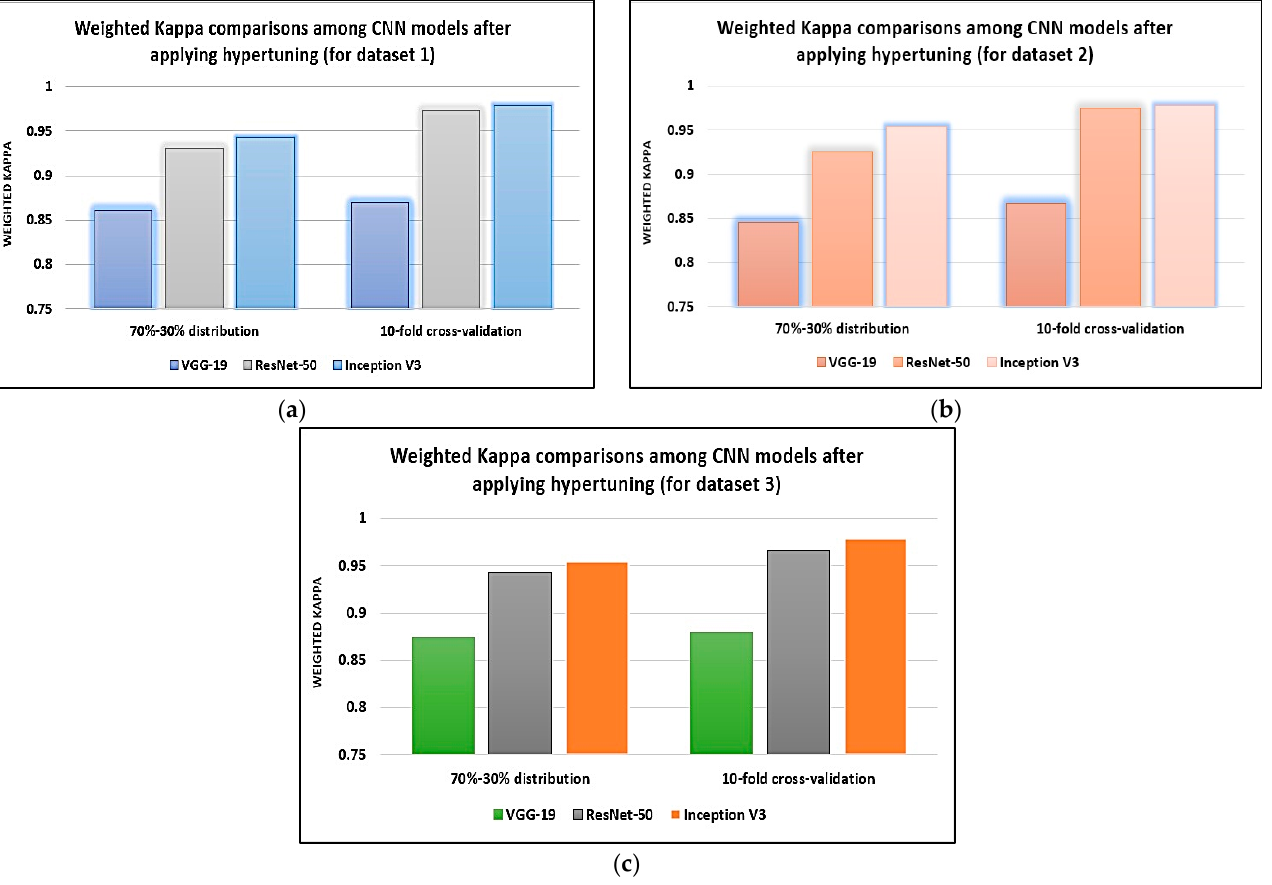
Figure 9. Comparison among VGG-19, ResNet-50, and Inception-V3 based on kappa statistic values for ( a ) dataset 1, ( b ) dataset 2, and ( c ) dataset 3.